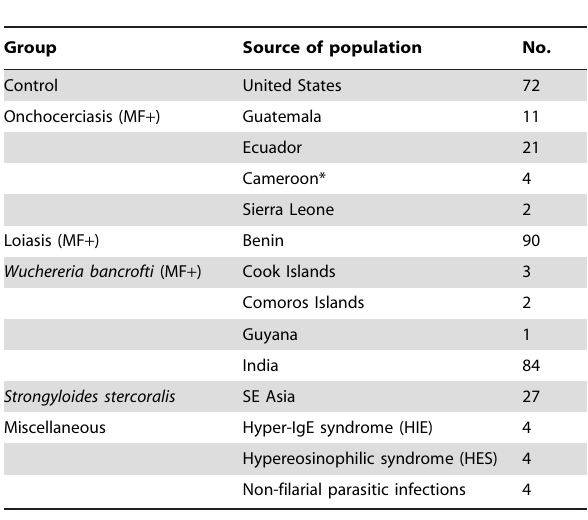
Table 1. Patient population for serologic